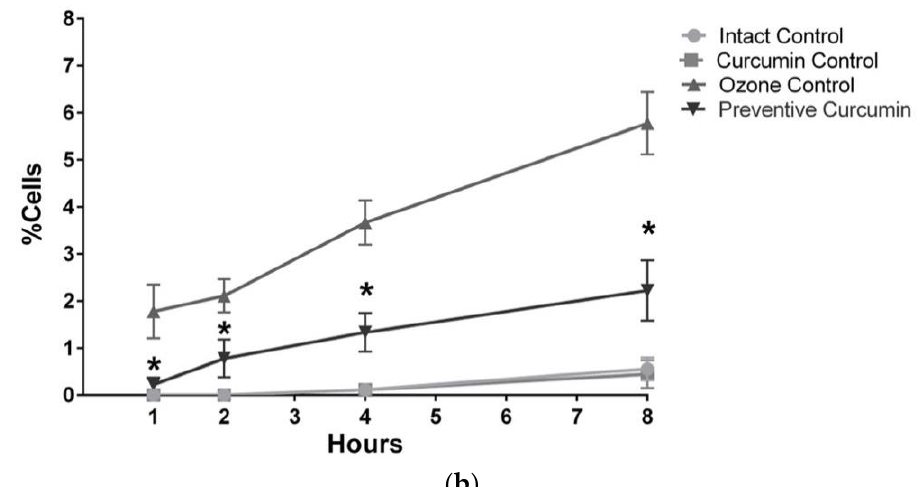
Figure 1. Effect of CUR against hippocampal neurodegeneration after short-term O 3 exposure (Table S1). CA1 region was evaluated by a modified silver technique (de Olmos stain). ( a ) This panel shows representative images of tissue sections at different O 3 exposure times in experimental groups ( n = 5), showing positive cells (dark brown), indicated with blue arrowheads, dashed lines indicate the CA1 area. ( b ) The graph illustrates the comparison of the degenerative cell percentage at each exposure time in experimental groups; results are expressed as mean values ± SEM, and the asterisk always indicates a statistical difference between the preventive curcumin and the ozone control groups ( p < 0.05). Data of intact control and curcumin control groups are overlapped in the two lines at the bottom.